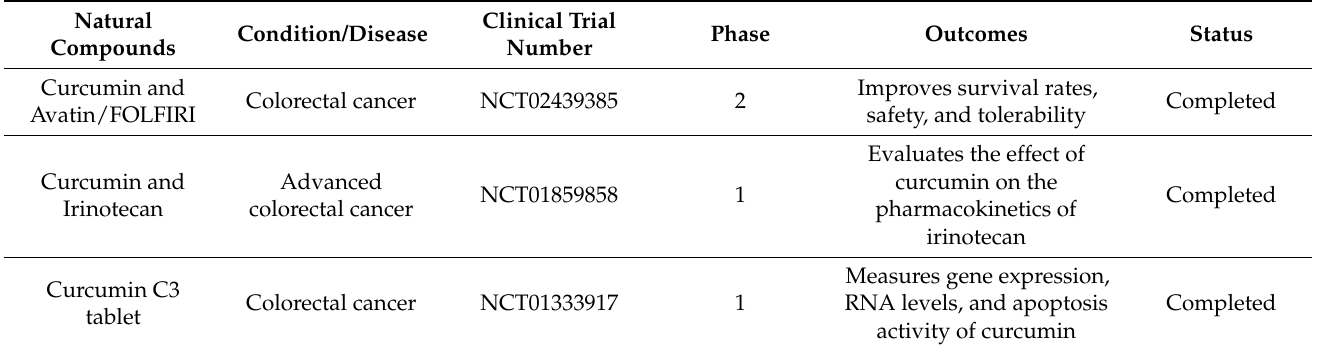
Table 2. A list of natural compounds that have undergone clinical trials for the treatment of colorec- tal